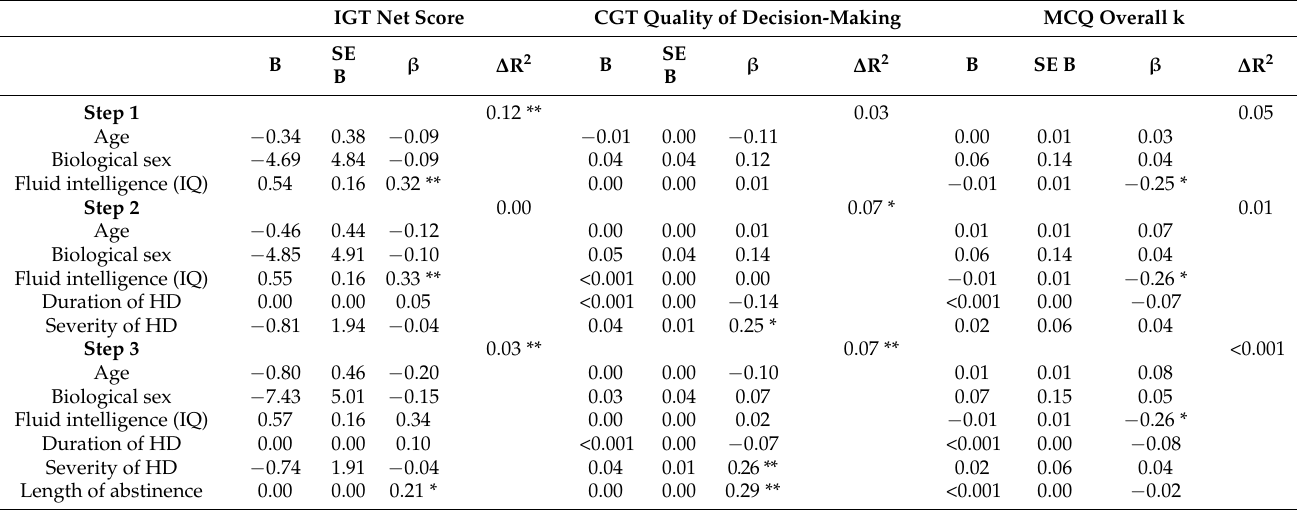
Table 4. Length of abstinence as predictor of IGT Net Score, CGT Quality of Decision-Making, and MCQ Overall